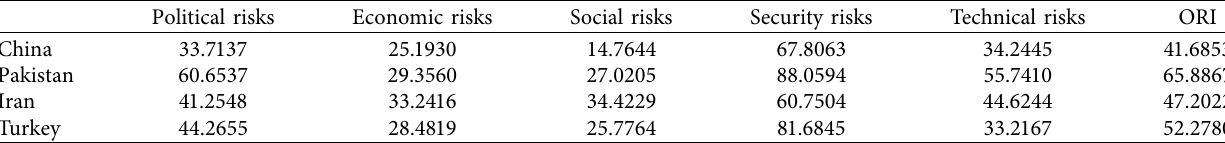
Table 2: The operational risk index of CPITC